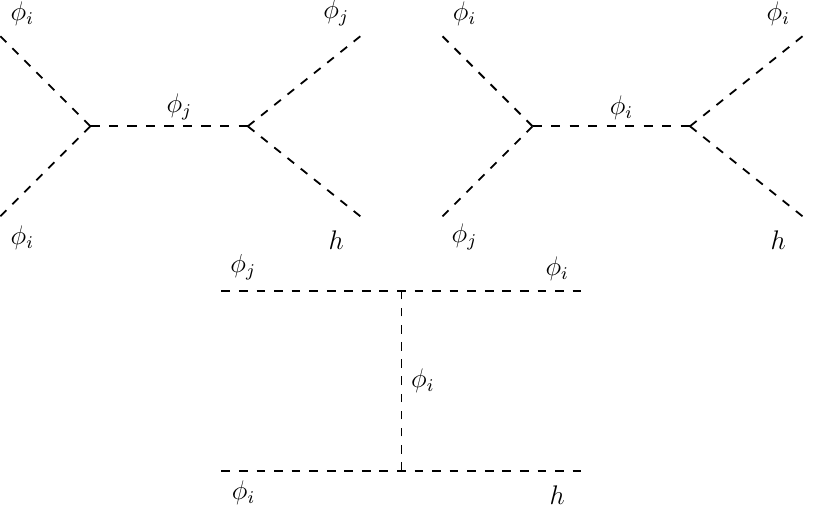
Figure 12 . (cid:30) i ; (cid:30) j DM semiannihilation channels via cubic interactions involving linear terms on (cid:30) i .